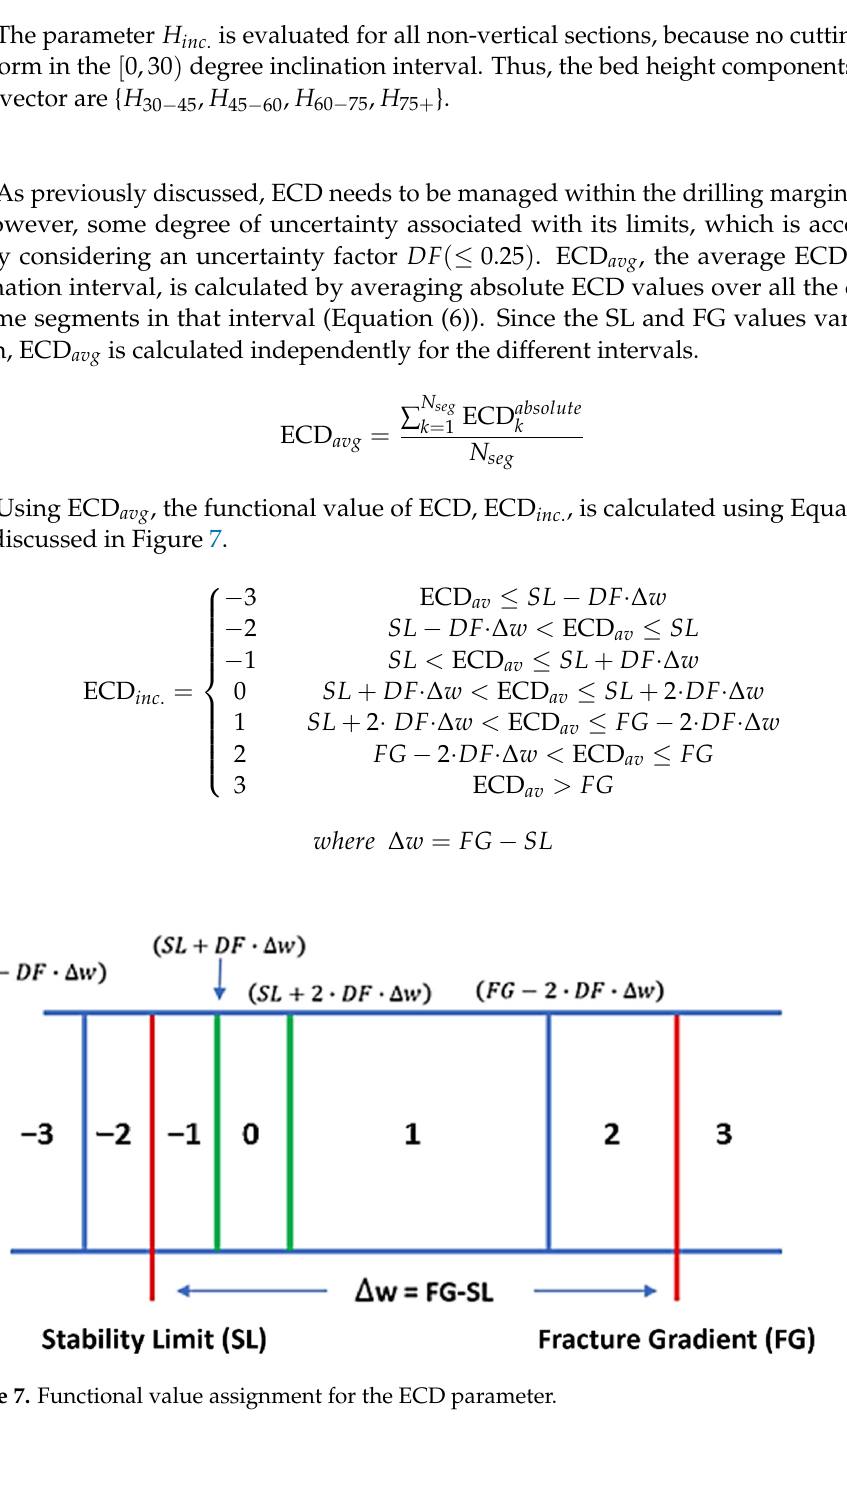
Figure 6. Functional value assignment for the cuttings bed height parameter.